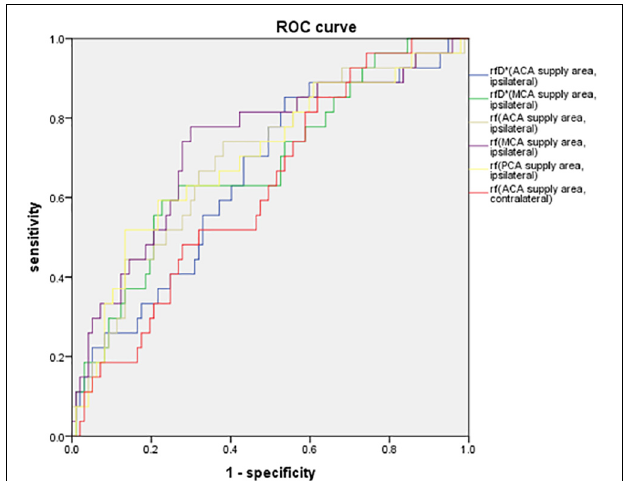
FIGURE 3 | ROC curve of rfD* in the ACA, MCA supply areas of the ipsilateral hemisphere, rf in the ACA, MCA, PCA supply areas of the ipsilateral hemisphere and in the ACA supply area of the contralateral hemisphere for predicting postoperative CHS. The AUCs of rf in the ACA, MCA, and PCA supply areas of the ipsilateral hemisphere for predicting postoperative CHS were 0.700, 0.733, and 0.701, respectively. The AUC for rf in the ACA